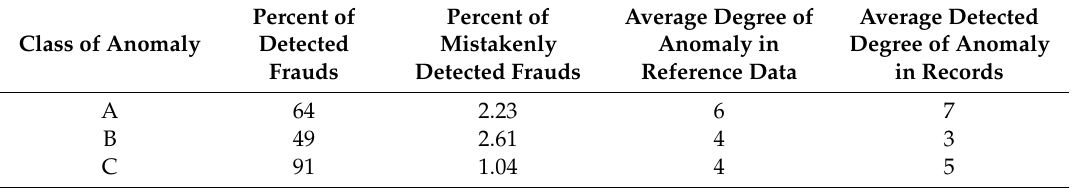
Table 6. Result of fraud detection analysis in customers with smart